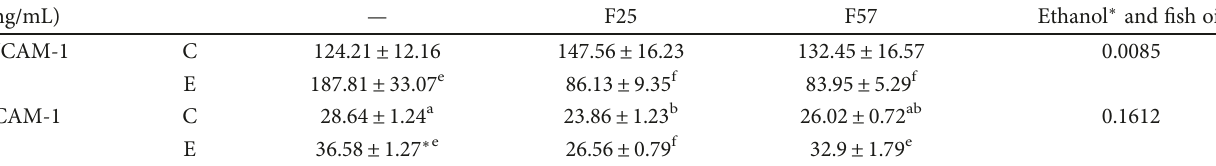
Table 7: Plasma vascular cell adhesion molecule (VCAM)-1 and intercellular adhesion molecular (ICAM)-1 levels of rats in each group 1,2 . (ng/mL) —